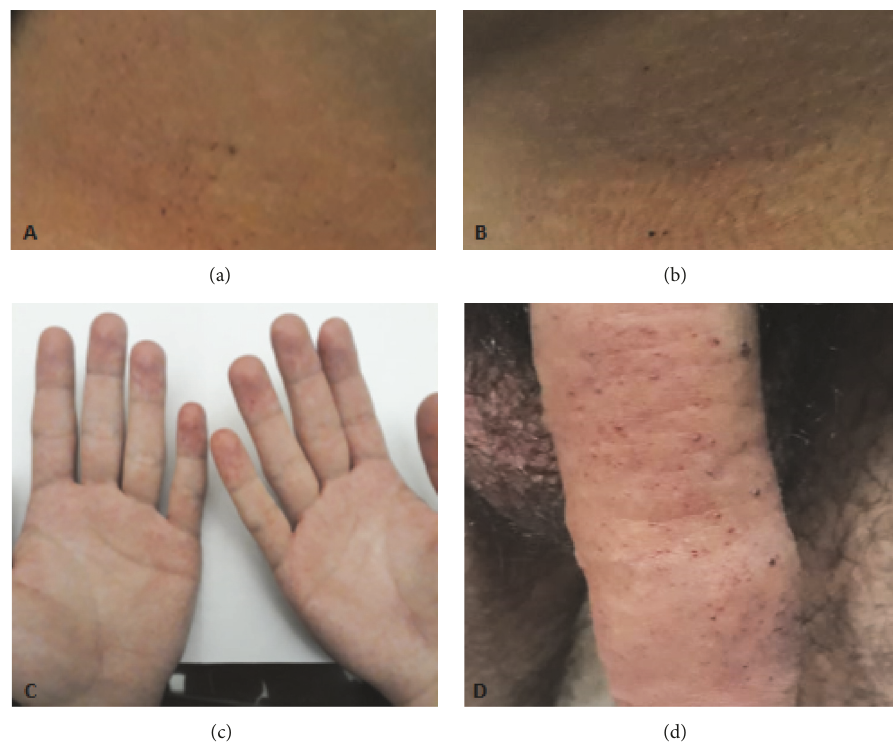
Figure 1: Typical skin lesions (angiokeratomas) of Fabry disease. (a) and (b) Angiokeratomas in lower abdomen skin. (c) Angiokeratomas in skin of hands. (d) Angiokeratomas in penile